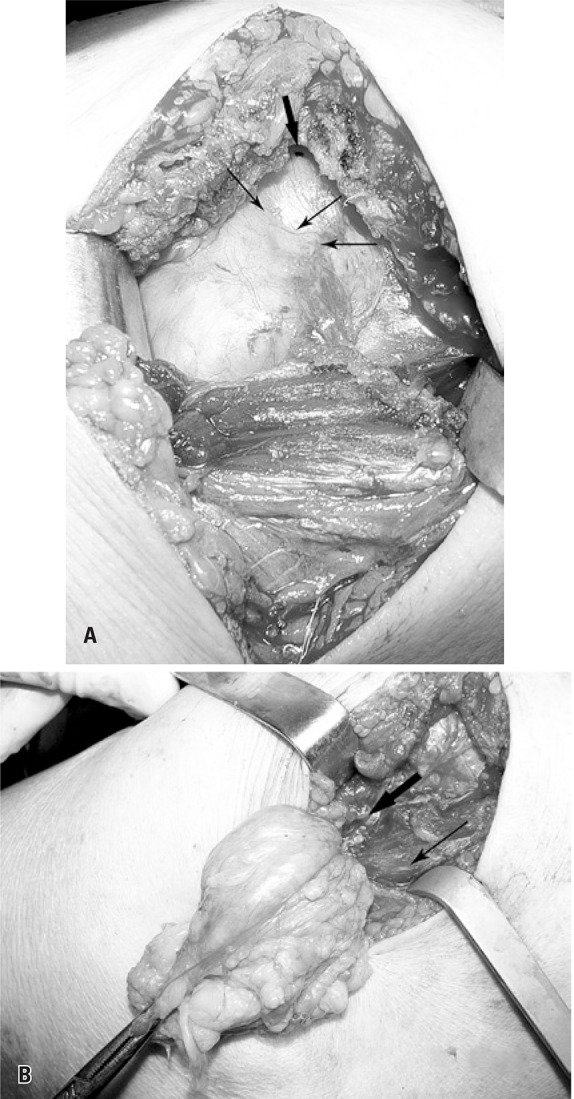
(A) Imagem intraoperatória mostra que o lipoma (seta estreita) não invade o espaço subacromial (seta larga). (B) Lipoma aderindo ao úmero, anteriormente ao tendão dos músculos redondo menor (seta estreita) e infraespinhoso (seta larga)